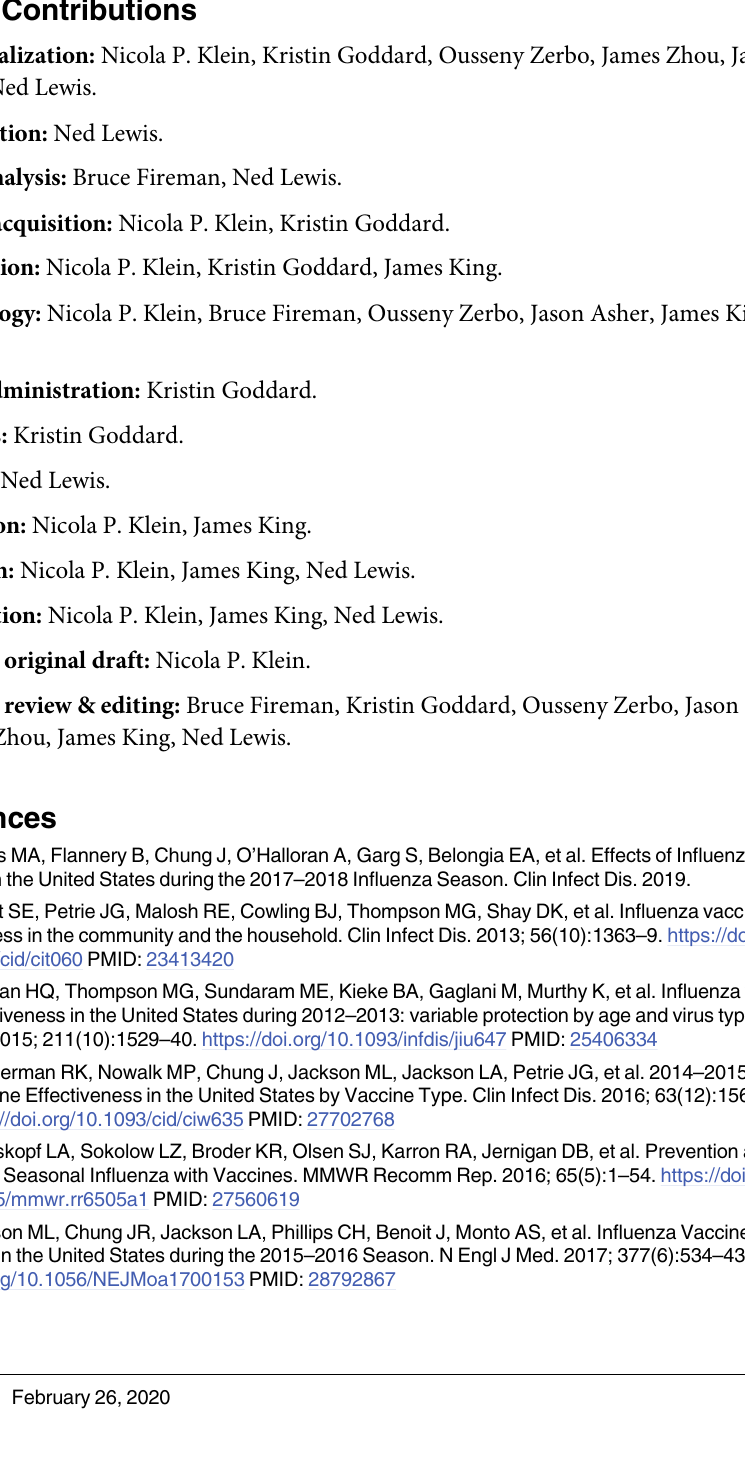
S2 Fig. Percent of all Influenza Vaccines that was Cell-Culture Inactivated Influenza Vac- cine (ccIIV4) by Week, Kaiser Permanente Northern California